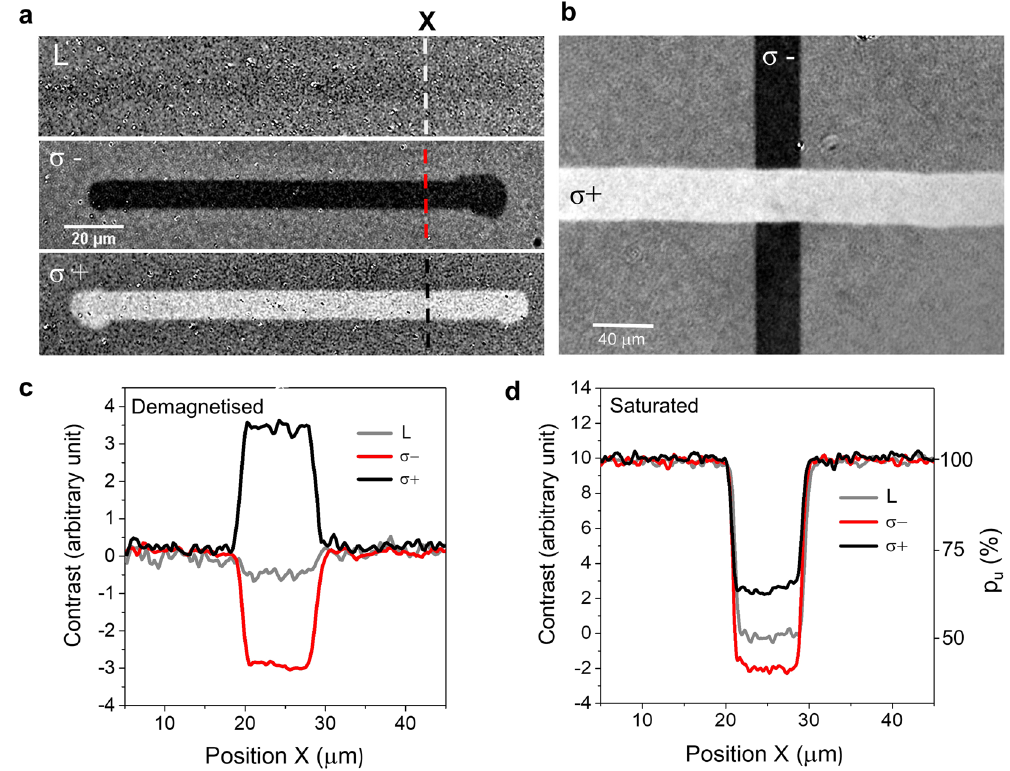
Figure 1. All-optical writing of a FePt recording medium. ( a) Magneto-optical contrast images, starting with a demagnetised state one obtains a reversed magneto-optical contrast for opposite helicities ( σ+ , σ− ) but not for linearly polarised light (L) along the line the laser spot has been moved. The number of laser pulses was here about 250 000 per spot. ( b ) Overwriting of the magnetisation direction is possible and reverses the magneto- optical contrast independently of the starting configuration. ( c ) Cross sectional contrast profiles along the dotted lines in ( a) starting with a demagnetised medium. ( d ) Starting with a saturated medium with 100% of M S ‘up’, gives a probability p u being in the ‘up’ state about 63% ( σ+ ) and 41% ( σ− ) respectively (magneto-optical contrast image not shown). The average laser power onto the sample was 7.5 and 15 mW (6.6 and 13.2 mJ/cm 2 per pulse), respectively. The magneto-optical contrast images in the saturated starting condition corresponding to the data in ( d ) can be found in the Supplementary